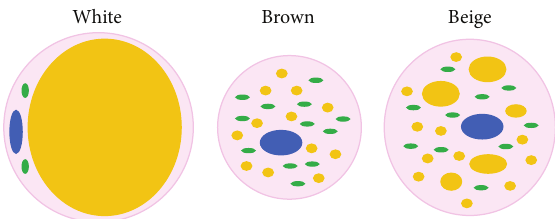
Figure 1: Main morphological characteristics of white, brown, and beige adipose tissues. White adipocyte cell is classically spherical, it is full of single lipid droplet, and it contains few mitochondria. Brown adipocyte is usually smaller than white and beige ones. It contains a large number of mitochondria and contains multiple small lipid droplets. Blue: nucleus, green: mitochondria, and yellow: lipid